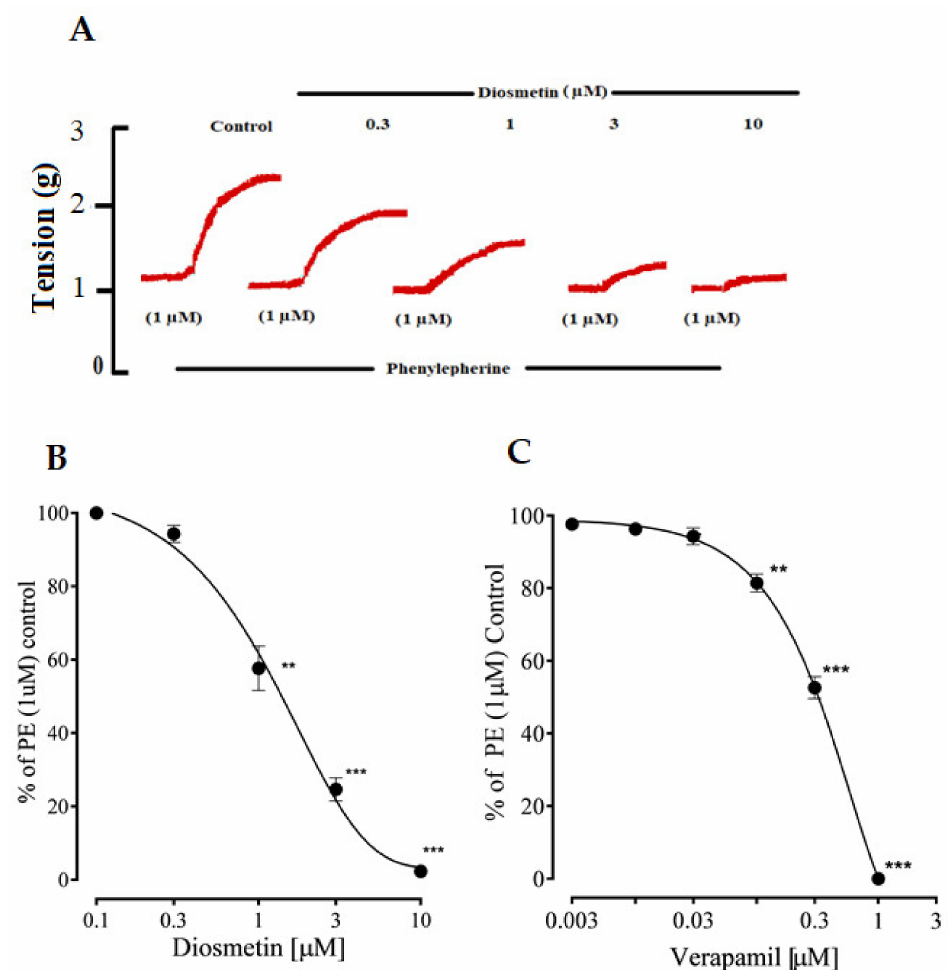
Figure 5. A representative tracing of ( A ) phenylephrine, which inhibited the presence of increasing concentrations of the diosmetin in the calcium-free medium; ( B , C ) the increasing concentrations of diosmetin and verapamil, respectively, which significantly inhibited phenylephrine (PE) peak formation in the calcium-free medium. Significant differences vs. control ( n = 6): ** p < 0.01; *** p <